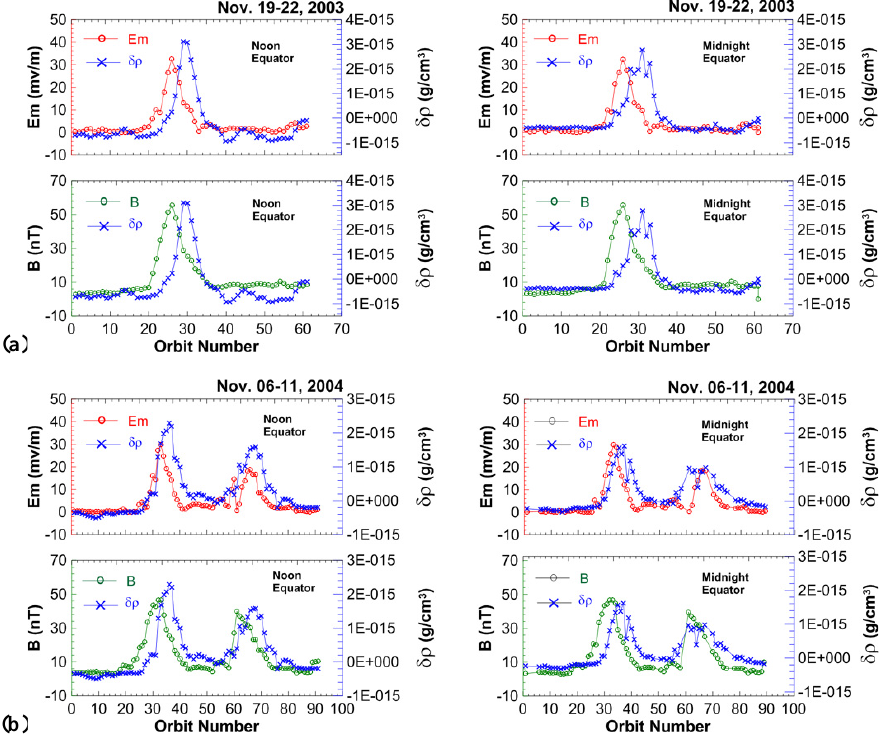
Fig. 3. Orbit (time) series of storm-time mass density changes, E m and B around equator at midnight and noon sector. (a) During 19– 22 November 2003; (b) during 6–11 November 2004. Blue line is for mass density changes, red for E m and green for B .